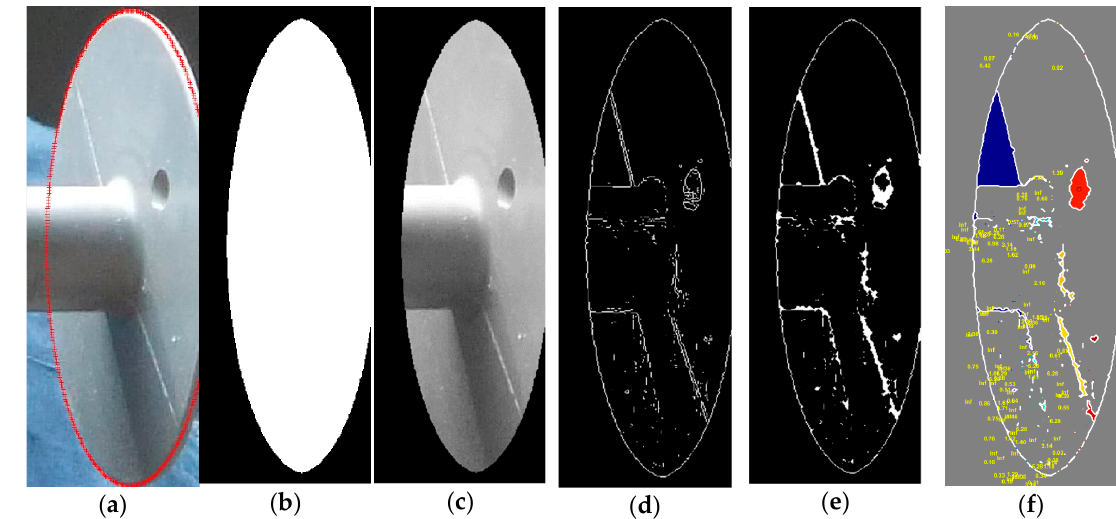
Figure 9. Proposed gunshot defect analysis algorithm. ( a ) Ellipse detection, ( b ) cap mask generated using the detected ellipse, ( c ) masked cap, ( d ) edge map of the masked cap, ( e ) morphologically enhanced edge map, ( f ) final detection result. A detected bullet shot marked with red color, while the numerical values in yellow color represent circularity values, in ( f ).